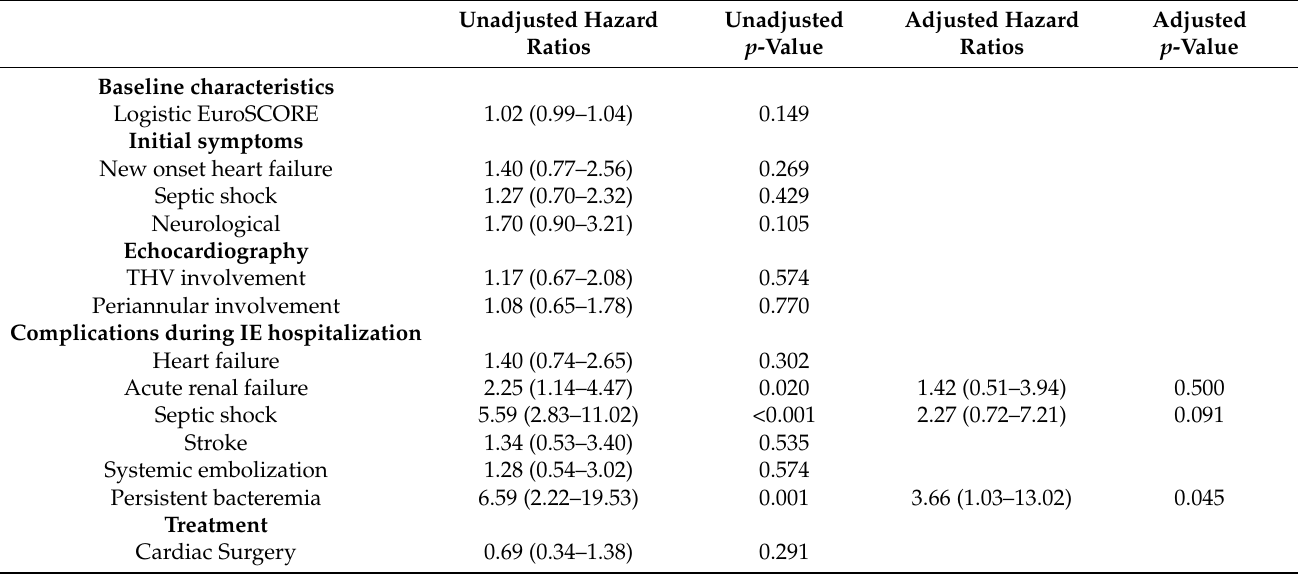
Table 5. Multivariate analysis of factors associated with 1-year mortality in staphylococci induced IE. Unadjusted Hazard Unadjusted Adjusted Hazard Adjusted p -Value p Ratios Ratios